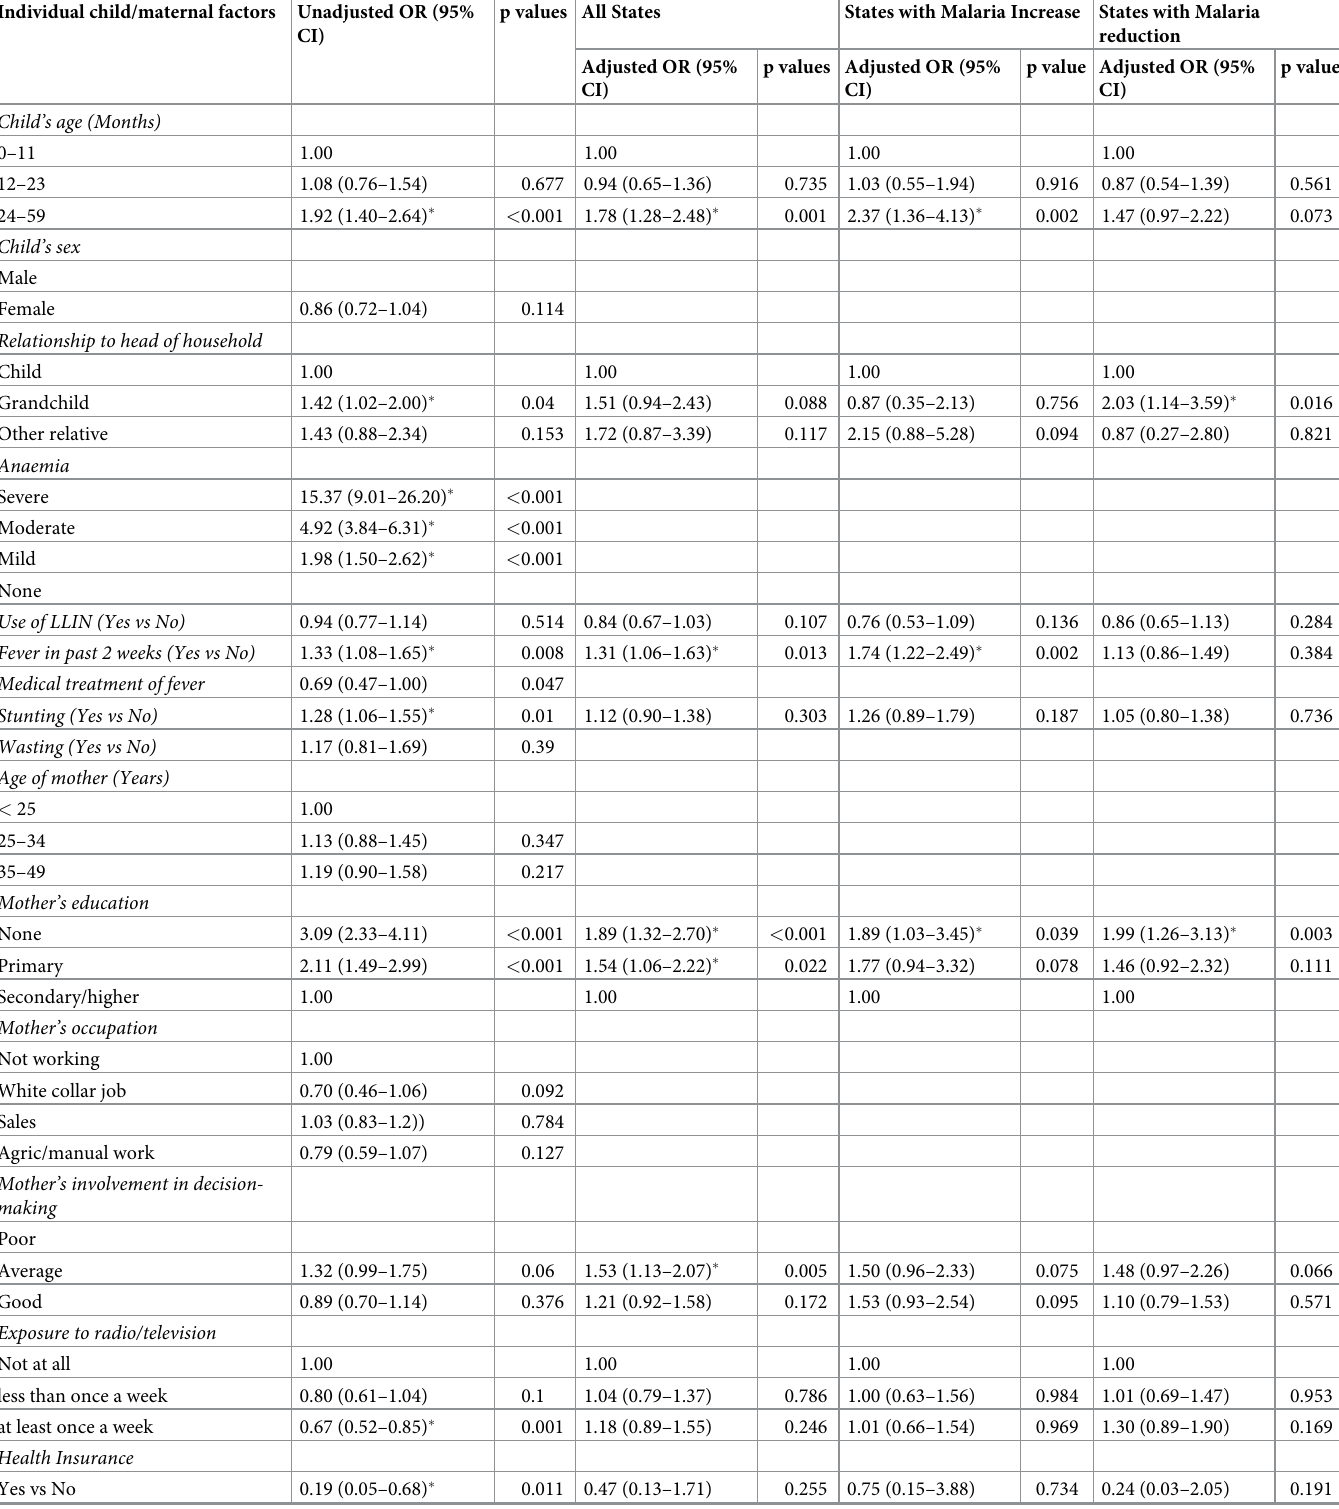
Table 6. Factors associated with parasitaemia among under-5 Children in 13 selected States of Nigeria (NDHS 2018). Individual child/maternal factors Unadjusted OR (95%